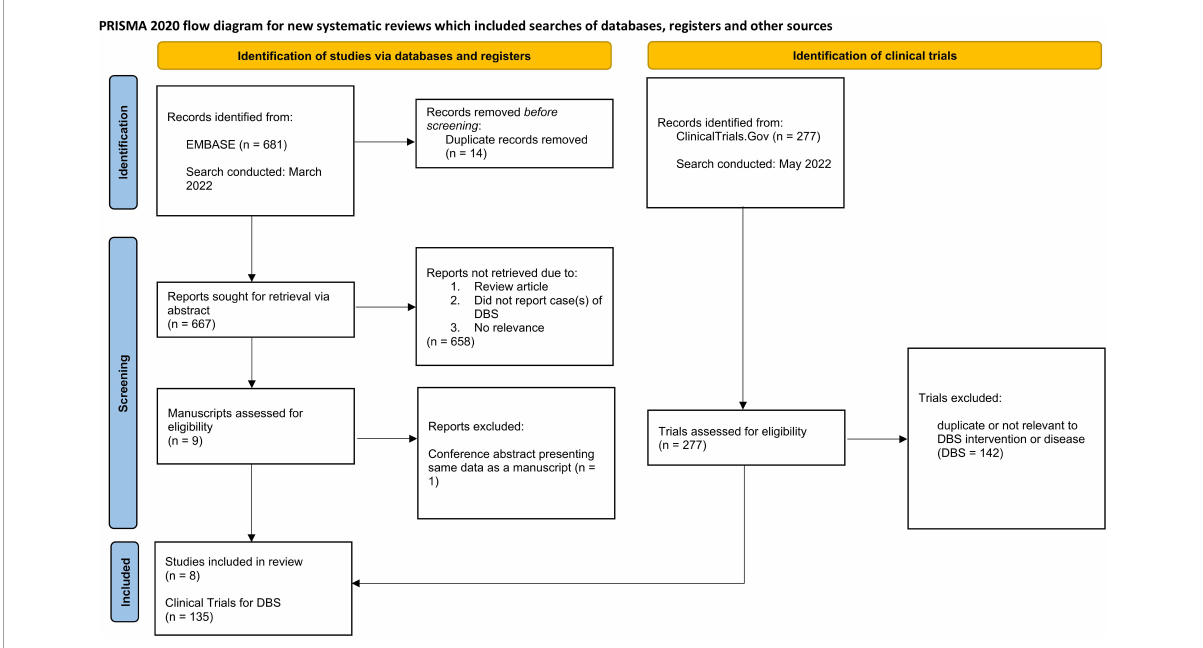
FIGURE1 PRISMA 2020 flow diagram for systematic reviews detailing collection of data from EMBASE (left) and clinicaltrials.gov (right) .